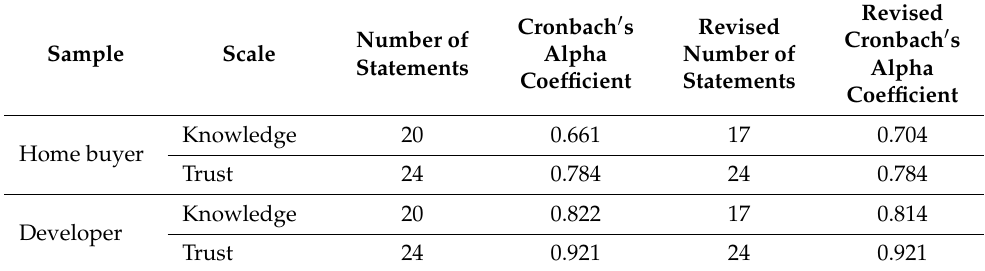
Table 5. Reliability coefficients.